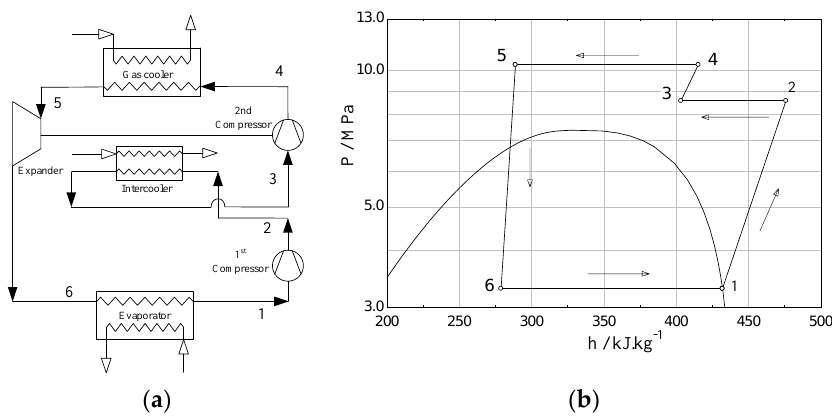
Figure 2. Schematic of TEDSC cycle and the corresponding P-h diagram. ( a ) Schematic diagram; ( b ) P-h diagram.